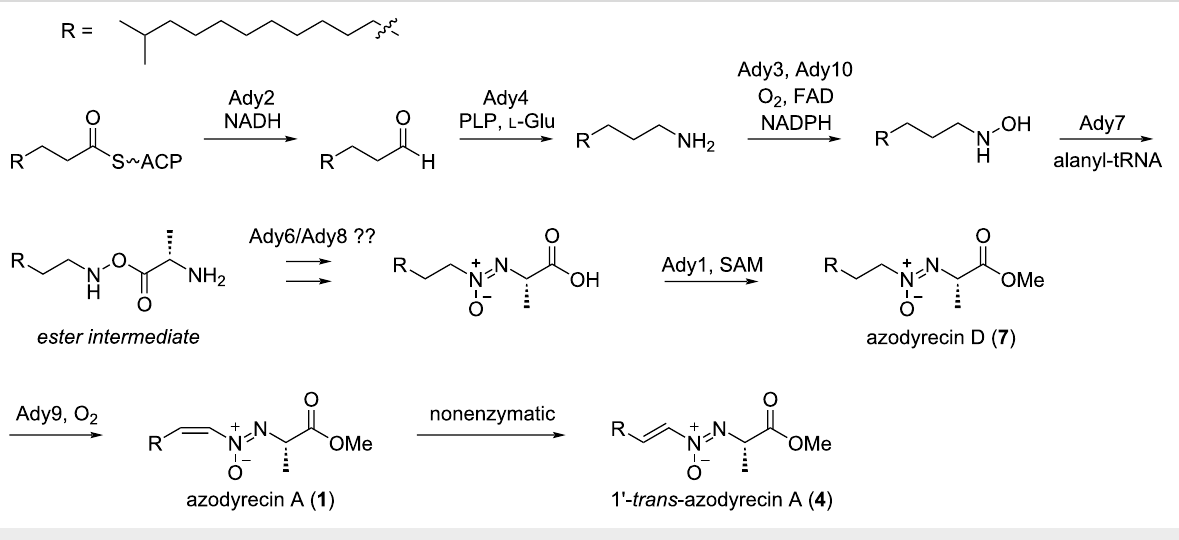
Scheme 2: Proposed biosynthetic pathway of azodyrecin.